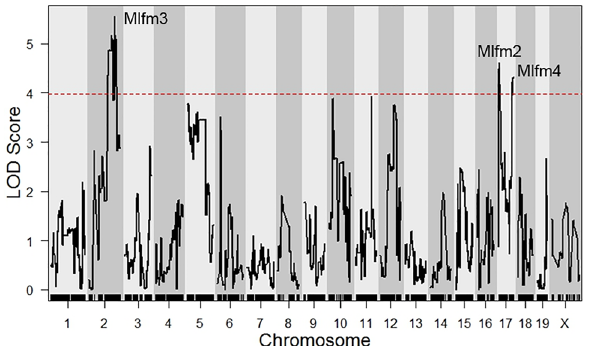
Figure 4. QTL mapping for lysosome function after adjusting for Mlfm1 as an additive co-variate. The dashed red line shows the genome-wide p = 0.05 threshold based on 10,000 permutations. QTL plot prepared using r/ QTL 44 .